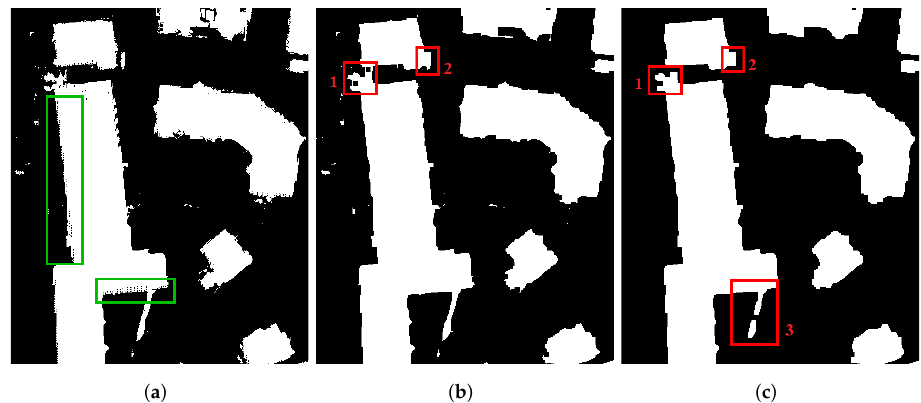
Figure 3. Illustration of preprocessing before the region matching of our building-mask refinement method. ( a ): An enlarged initial building mask, which is part of Figure 1d. ( b ): ( a ) after being processed by the first morphological closing operation. ( c ): ( a ) after being processed by both the first morphological closing and the first morphological opening